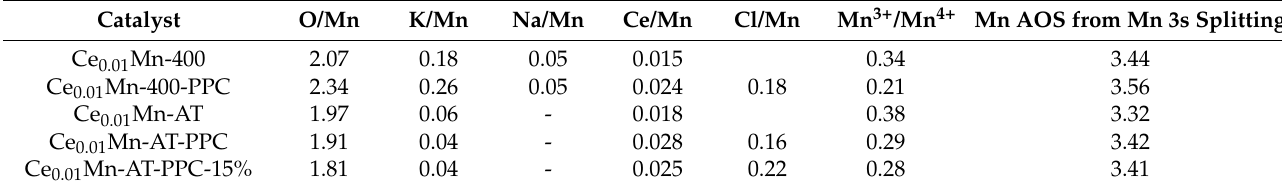
Figure 13. Decomposition of XPS ( a ) Mn2p 3/2 and ( b ) Cl2p core levels after the PPC process. Table 3. Semi-quantitative XPS analysis for used (PPC) catalysts.